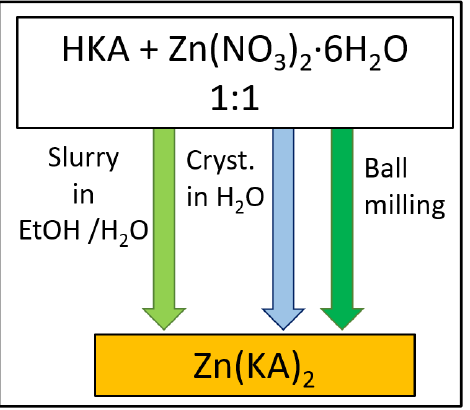
Figure 2. Square-pyramid polyhedra of oxygen atoms around the copper(II) cation in Cu(KA) 2 ( a ); the 1D zig-zag chains are shown here ( b ); side-by-side, linked via O - ∙∙∙ (H)O CHOH hydrogen bonds ( c ). Copper ions are in dark orange.